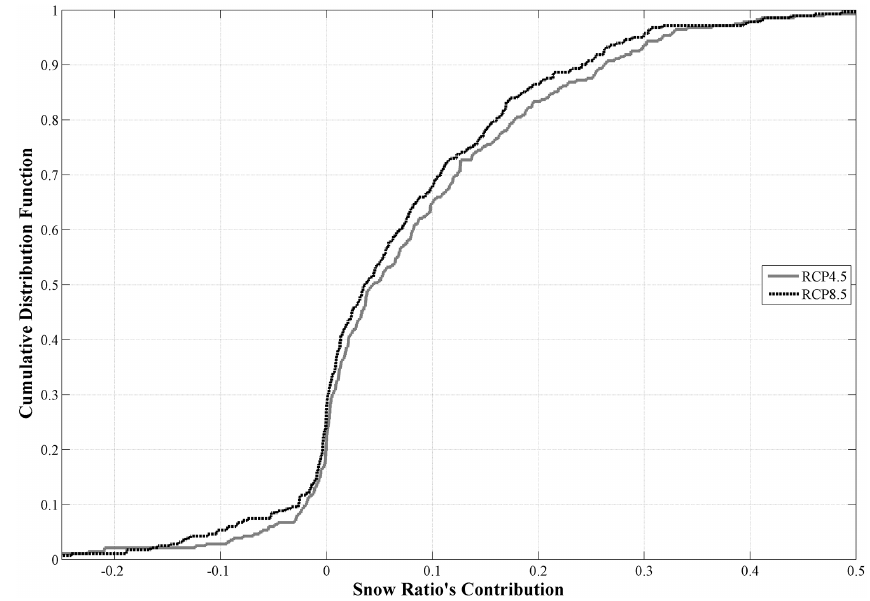
Figure 10. Cumulative distribution function of snow ratio’s contribution to runoff change under projected future climate.